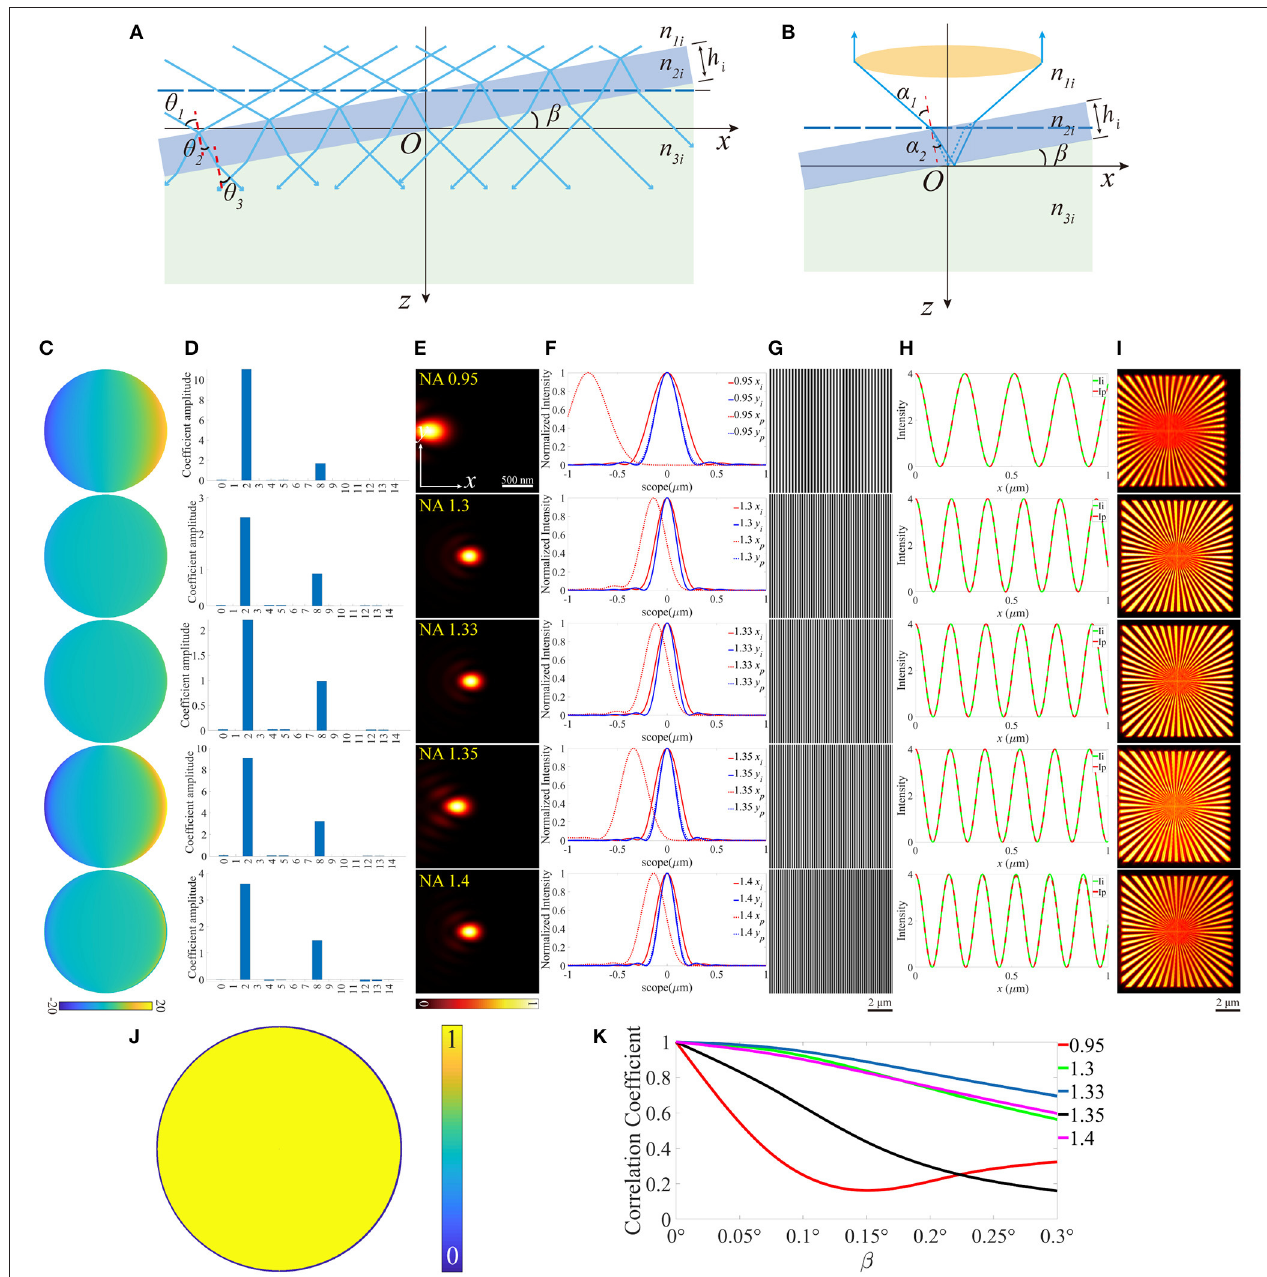
FIGURE 5 | The diagrams of the illumination path and the detection path for a tilted coverslip, and the corresponding results for β = 0.3 ◦ . (A,B) The tilted coverslip mode in the illumination path and the detection path. (C) The pupil functions calculated from the case depicted in (B) . (D) Zernike decomposition of the pupil functions shown in (C) , the first 15 orders of modes are used. (E) The PSFs on the plane z = 0, calculated with the pupil functions shown in (C) . (F) The profiles of the ideal and biased PSFs in (E) . (G) The excitation patterns affected by the aberrations. (H) The profiles of the excitation pattern shown in (G) , the scope is 0 ∼ 1 µ m. (I) The reconstruction images of SIM. (J) The effective pupil for NA = 1.4. (K) The correlation coefficients of the reconstructed images and the corresponding slope angle β .